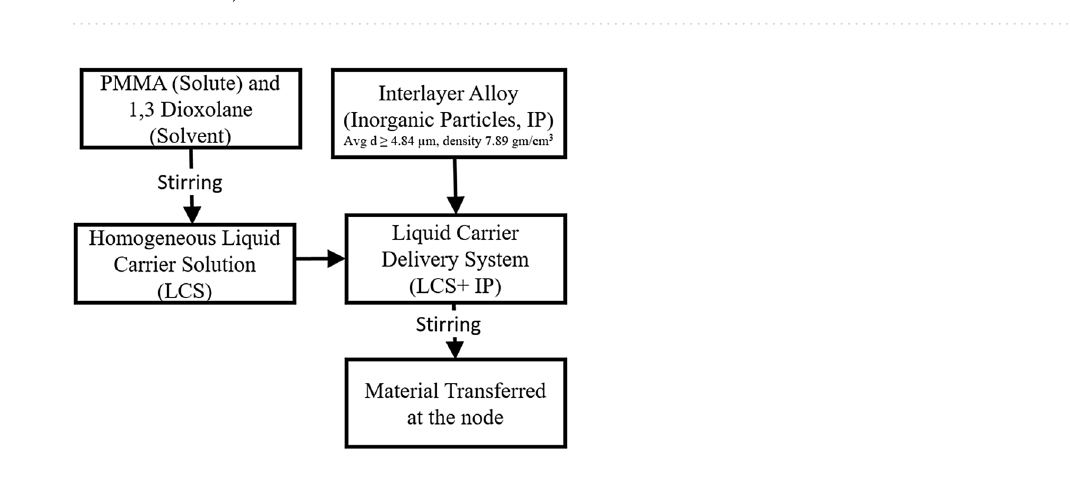
Figure 13. Flowchart of interlayer material suspension